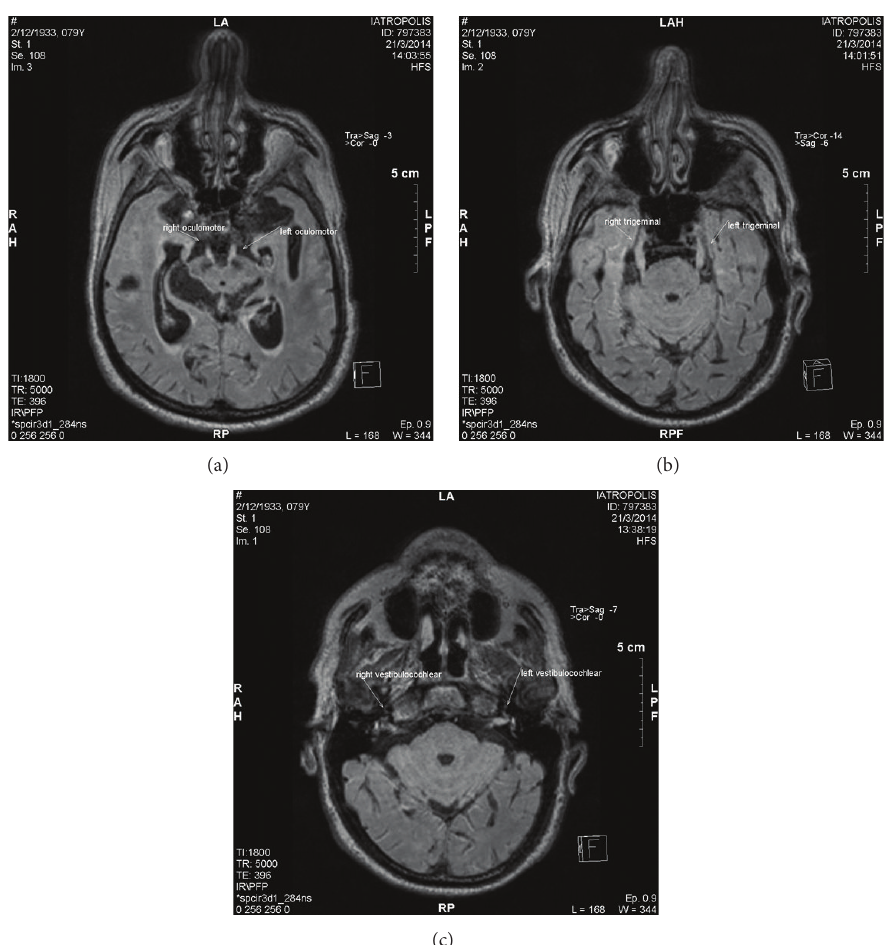
Figure 1: The MRI of the brain showed enhancement of the left trigeminal (a) and both oculomotor (b) and vestibulocochlear nerves (c) and signs of leptomeningeal